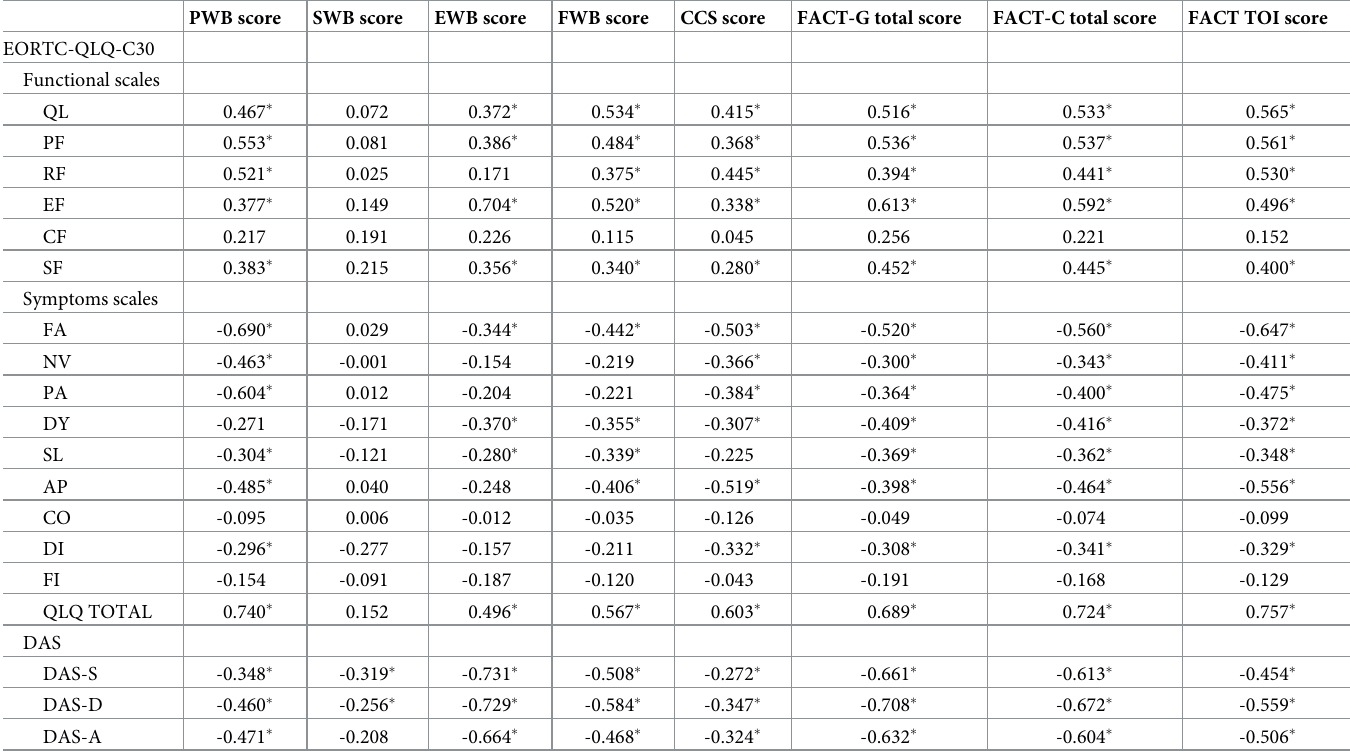
Table 4. Concurrent validity (Pearson correlation) of the Functional Assessment of Cancer Therapy-Colorectal (FACT-C).